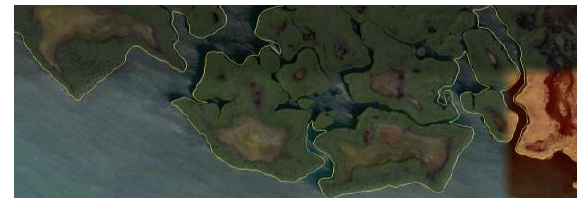
Figure 7. Result of the vector generated over a vegetation coastal sector.